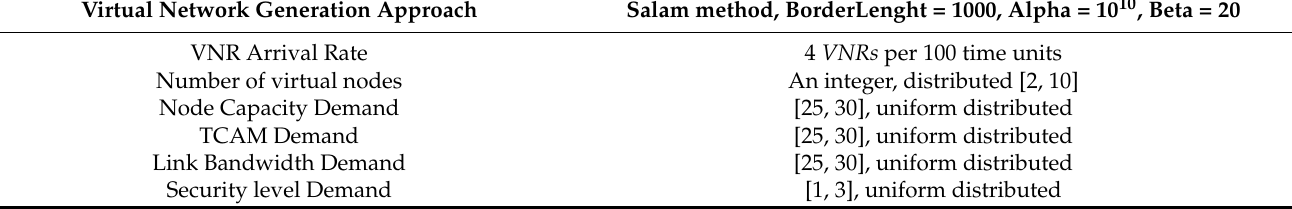
Table 3. Virtual